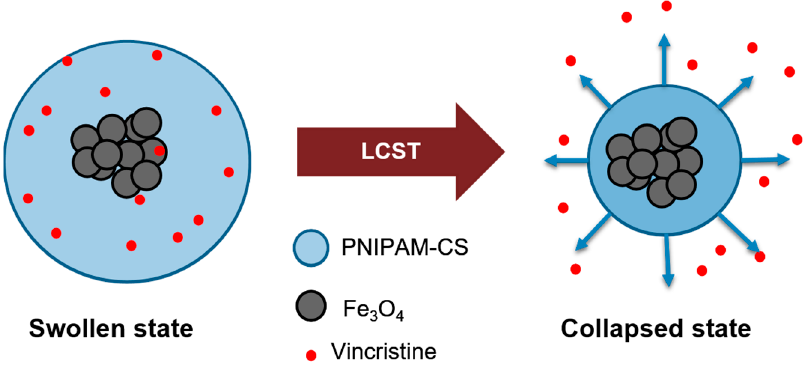
Figure 1. Illustrative schematic of the nanocomposite (Fe 3 O 4 @PNIPAM-CS-Vincristine) performance and the kinetics of swelling and collapse.